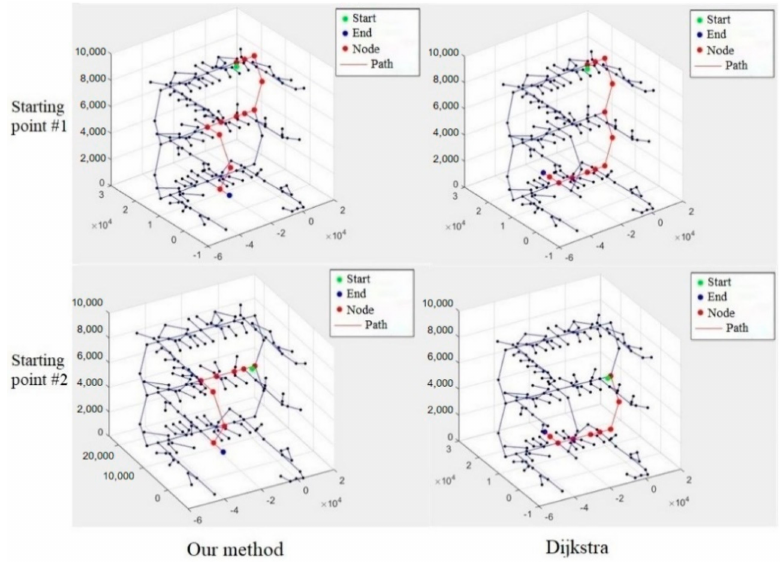
Figure 25. Comparison between our method and Dijkstra.